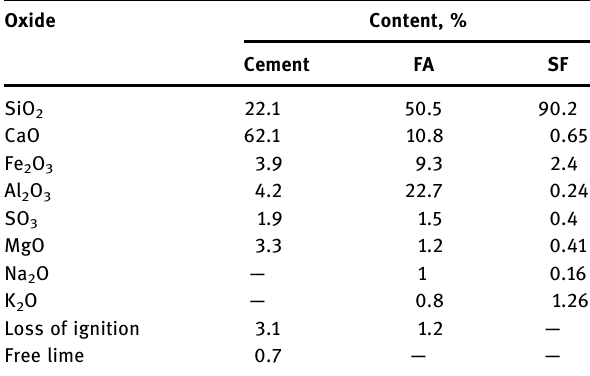
Table 1: The chemical composition of cement, SF, and FA